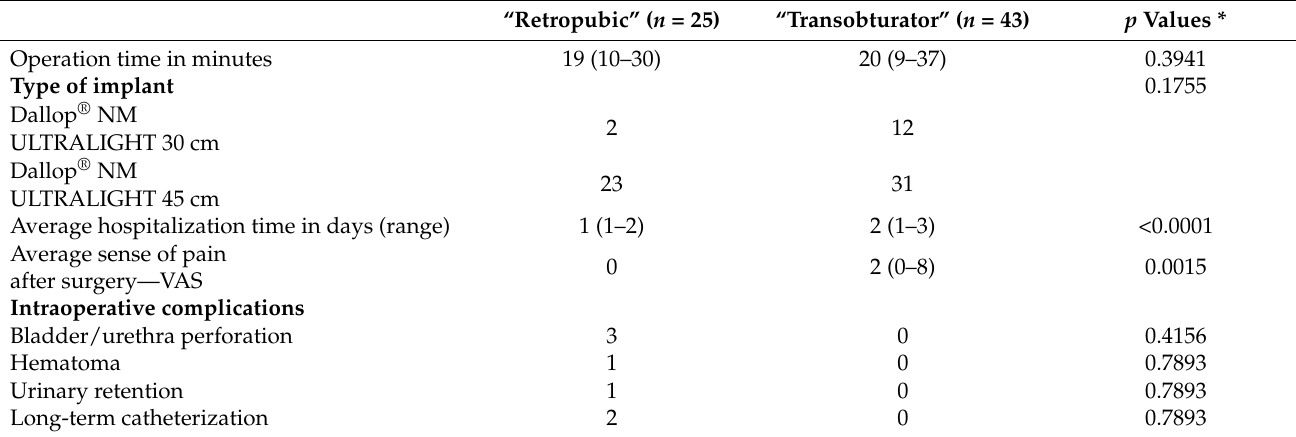
Table 2. Intraoperative complications, surgery time, and the length of